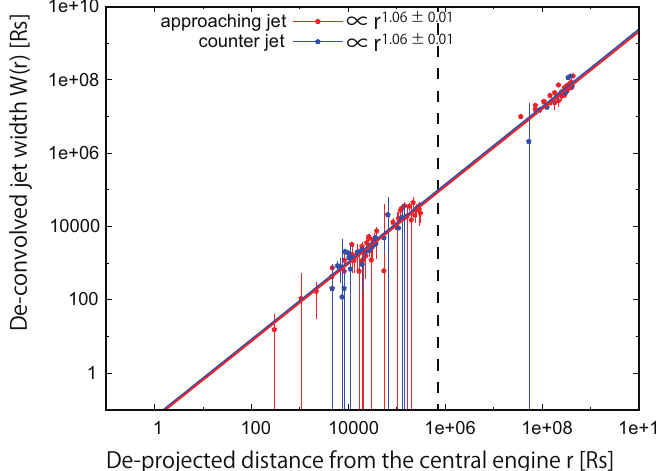
Figure 2. Radial profile of measured jet width for NGC 4261. The horizontal axis shows distance from the central engine, which is taken into account for the core shift effect. The vertical axis shows deconvolved jet width. Red and blue circles represent measurements of approaching and counter jets, respectively. The red and blue lines represent fitted profiles of approaching and counter jet widths, respectively. The dashed line indicates the Bondi radius of NGC